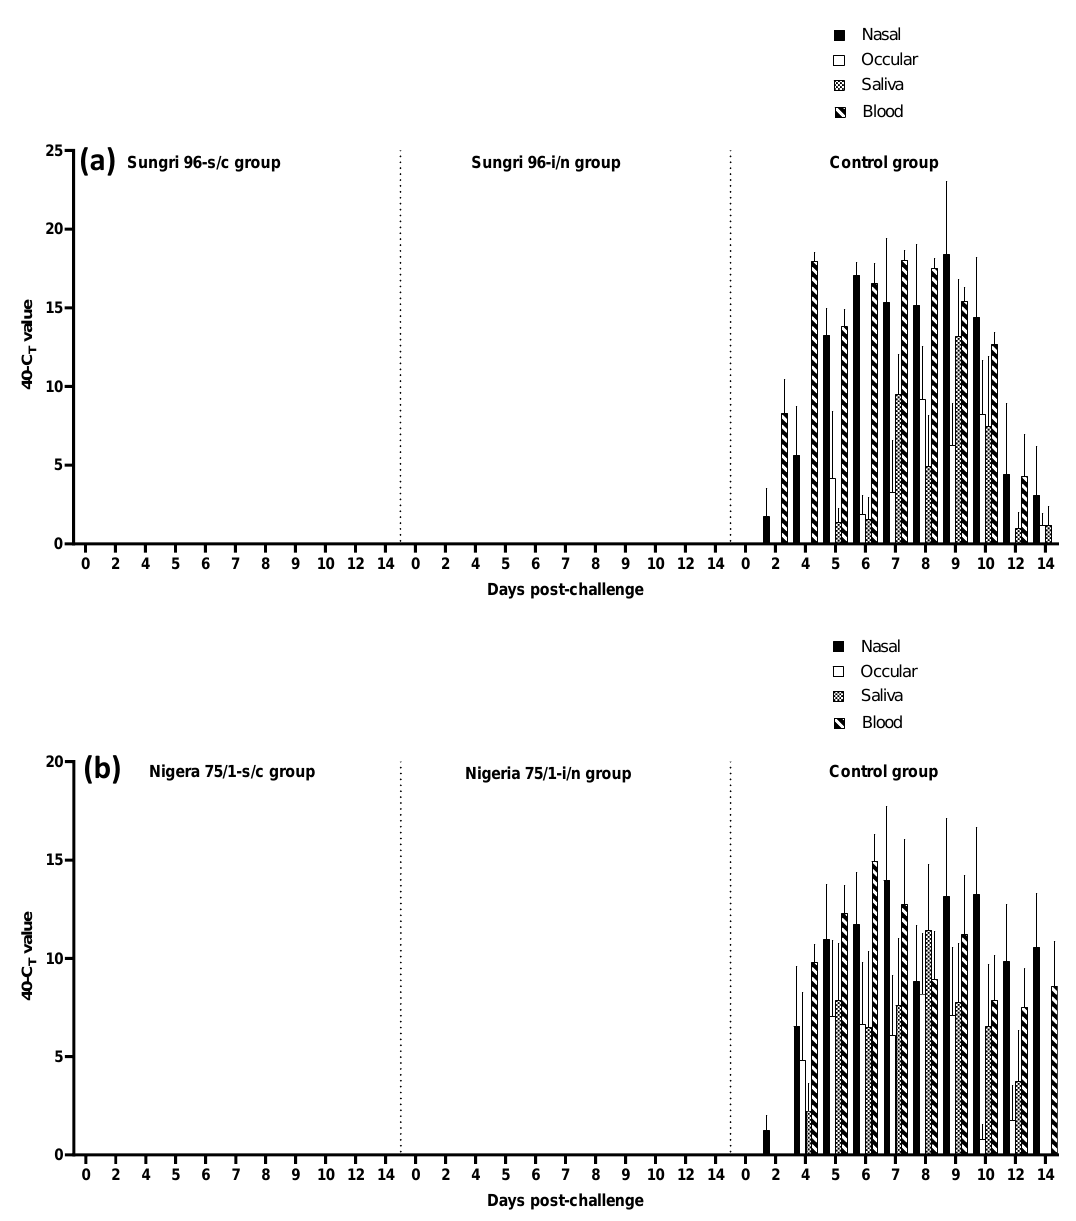
Figure 2. PPRV-specific RNA was measured by reverse-transcription — real-time PCR (RT-qPCR) and the amount of viral RNA is expressed as the mean 40- C T value, a value which increases as the amount of viral RNA increases. Average values for five animals in each group on different days post-challenge are shown. ( a ) Nigeria 75/1 vaccine study; ( b ) Sungri 96 vaccine study.